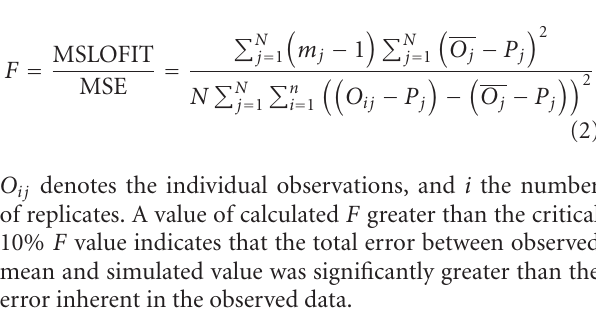
Figure 1: Simulated and observed NO 3 − -N leaching [gN m − 2 ] (accumulated values) from the control treated (only NPK Fertilizer) lysimeters. The SOILN NO model is calibrated to match the observed values by adjusting the initial amounts of C and N in the soil organic matter pools litter 1, litter 2, and